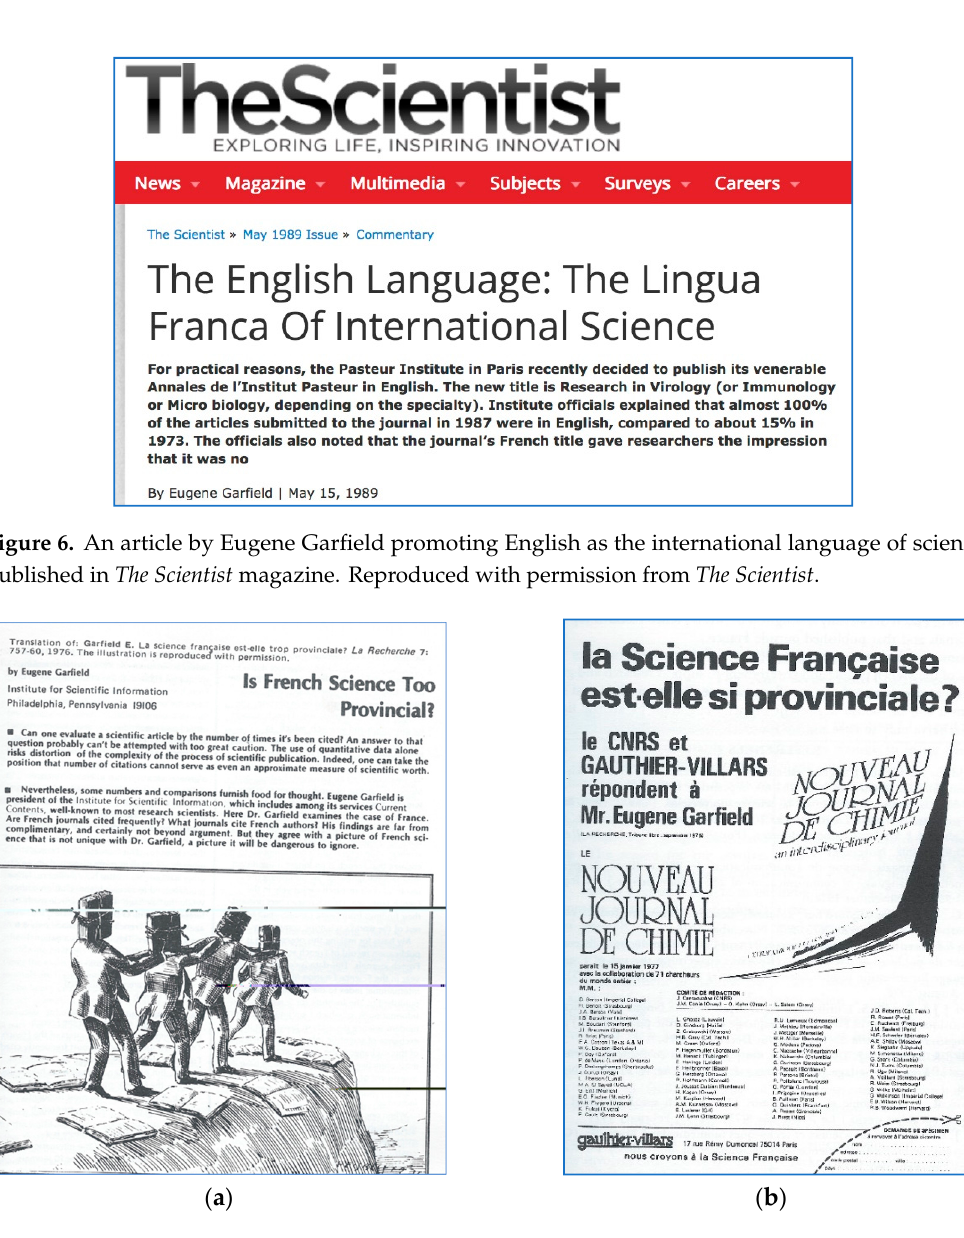
Figure 7. Garfield published an article in the French journal La Recherche under the provocative title “Is French Science Too Provincial?” ( a ) A picture of the translation of this article in English. ( b ) The French reacted by launching a new multi-language chemistry